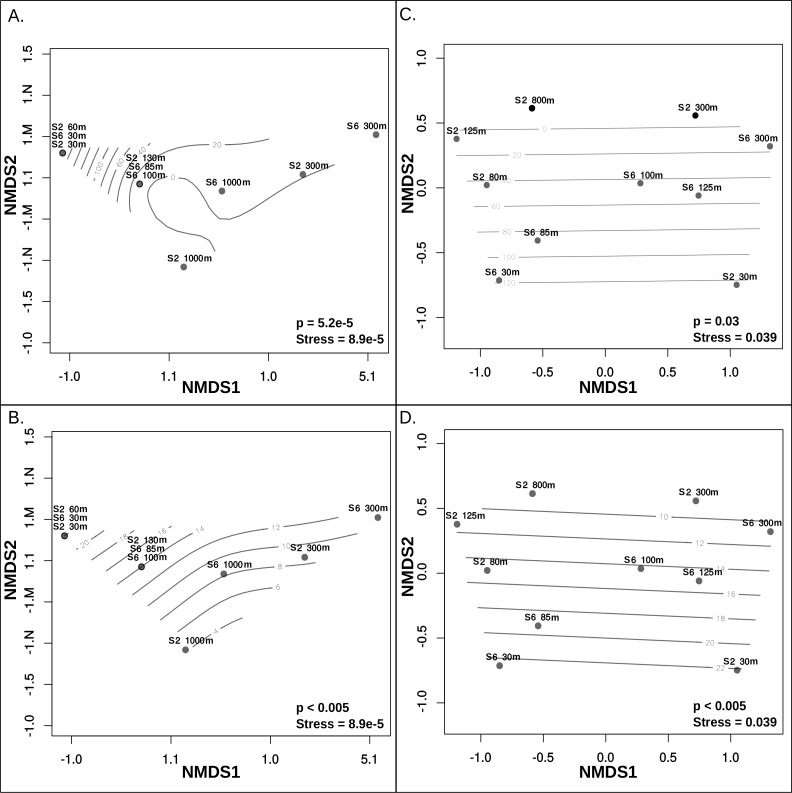
Non-metric multidimensional scaling analysis of ETNP putative archaeal virus and Archaea population distribution in relation to environmental variables.Measurements of temperature, oxygen, salinity, chlorophyll a, and depth were examined to determine which of these features influences the separations among both archaeal virus populations and Archaea in each habitat. Oxygen concentration (A) and Temperature (B) most significantly influenced the ETNP archaeal virus population distribution non-linearly. Oxygen concentration (C) and Temperature (D) also have a linear impact on the distribution of the Archaea. Depth was also found to significantly influence archaeal virus population distributions but this is likely due to a co-variable effect with oxygen and temperature. Salinity and chlorophyll a do not exhibit a significant correlation with the archaeal virus or archaeal population distributions.